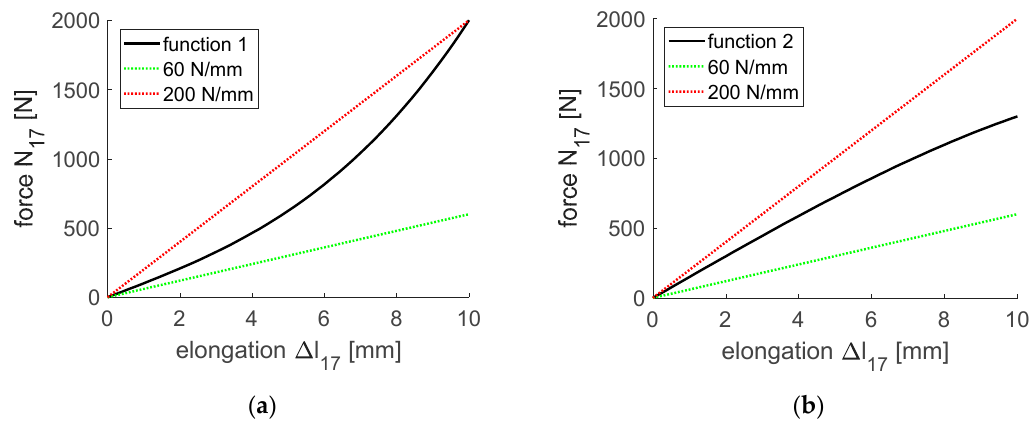
Figure 13. ANN obtained in example 2: ( a ) architecture, ( b ) performance of training.